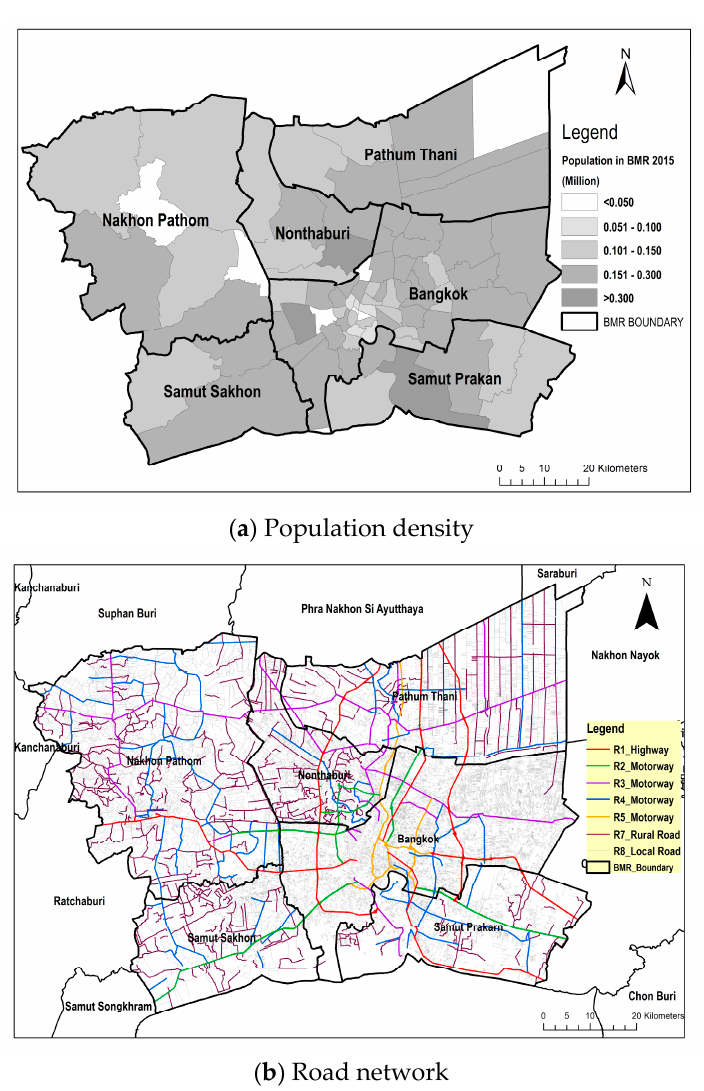
Figure 2. Demography and road structure in the BMR area. ( a ) Population density, ( b ) Road network.